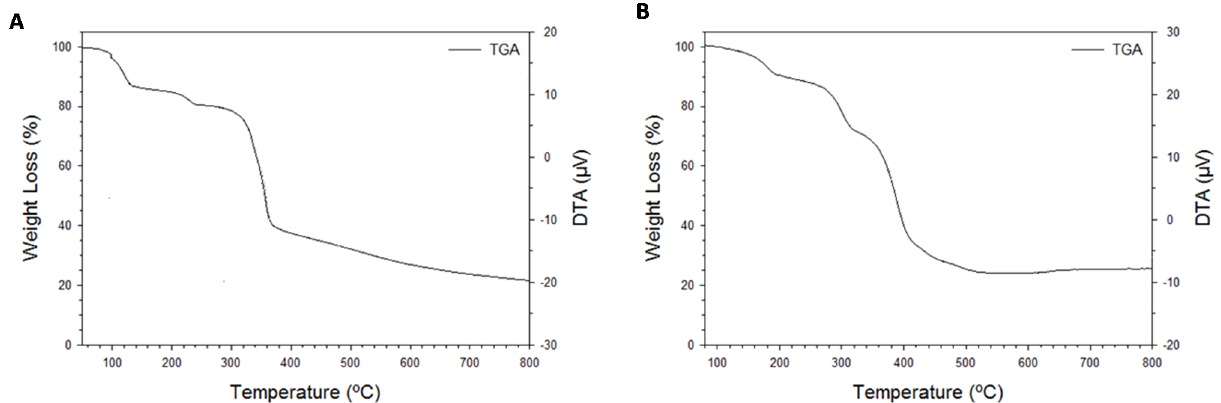
Figure 5. Thermal gravimetric (TG) analyses of ( A ) Cu(HBTC)·3H 2 O and ( B ) Zn(ADC)·DMSO crystals harvested from gold surfaces after pillared